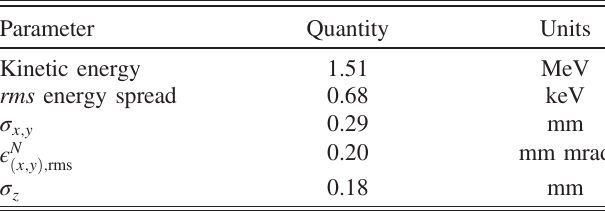
TABLE VIII. IMPACT-T tracking results at gun